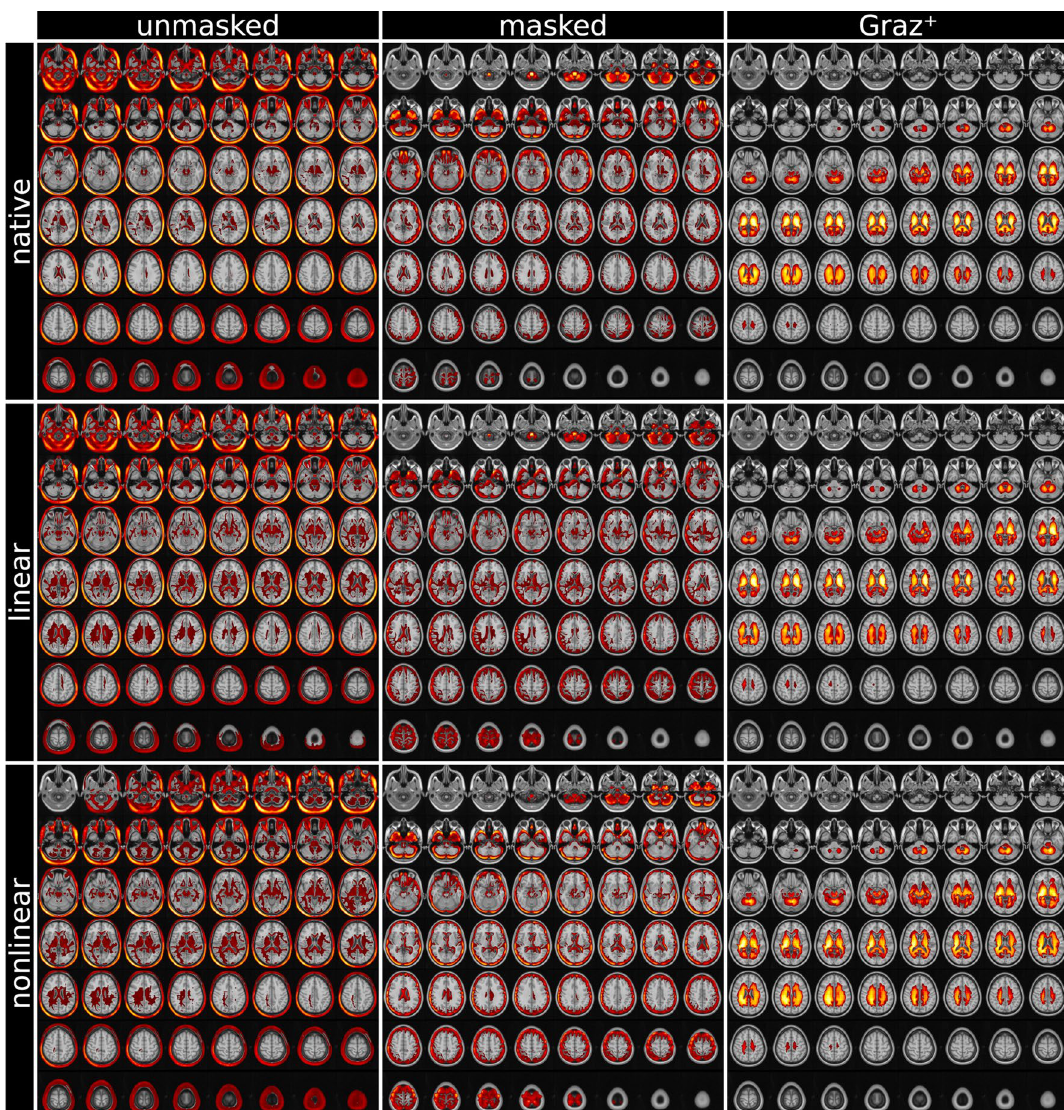
Figure 5. MNI152 template overlaid by mean relevance maps (highest relevance in yellow) obtained for all nine models. Unmasked and masked MRI classifiers obtain relevant image features from volumetric information (left and center columns). In contrast, the proposed Graz + -method bases the classifier’s decision on deep brain image features, virtually independently of the registration method (right column). Heat maps are thresholded to the top 50% of the overall relevance. See “Methods” for ods also identified some relevant voxel clusters in deep gray and white matter adjacent to the lateral ventricles (center of the brain), which were substantially smaller. Given the spatial distribution of the relevances, we argue that the two conventional CNN models are over- whelmingly sensitive for global volumetric features. Complementary volumetric analysis using an established neuroimaging tool for brain segmentation (FSL-SIENAX) in a logistic regression model yielded a balanced accu- racy of 82%, which is on par with the top CNN results. Here we want to highlight that FSL-SIENAX volumetry